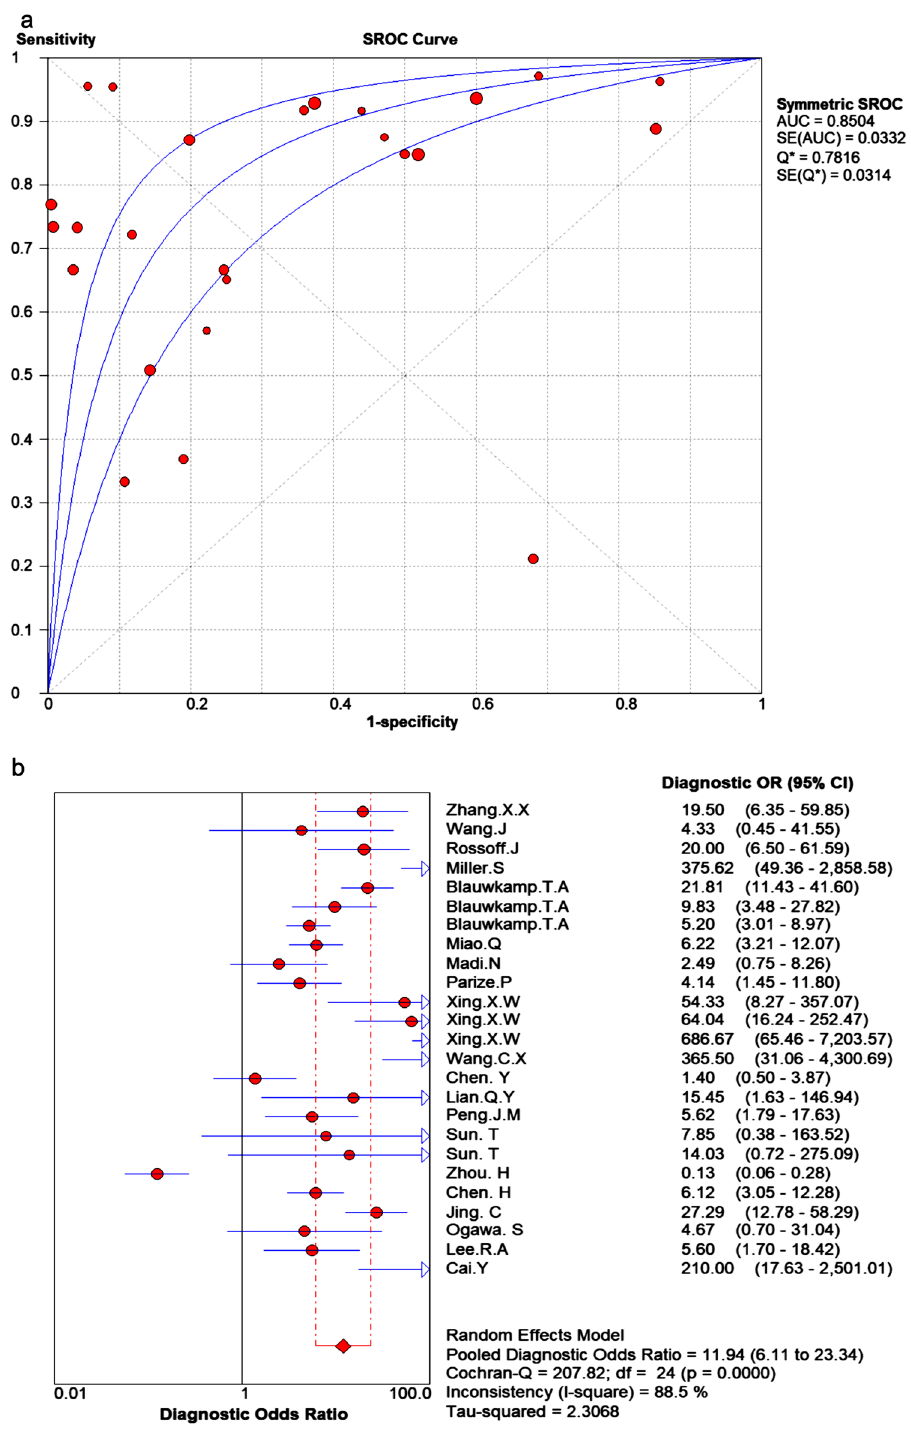
Figure 5. Summary ROC